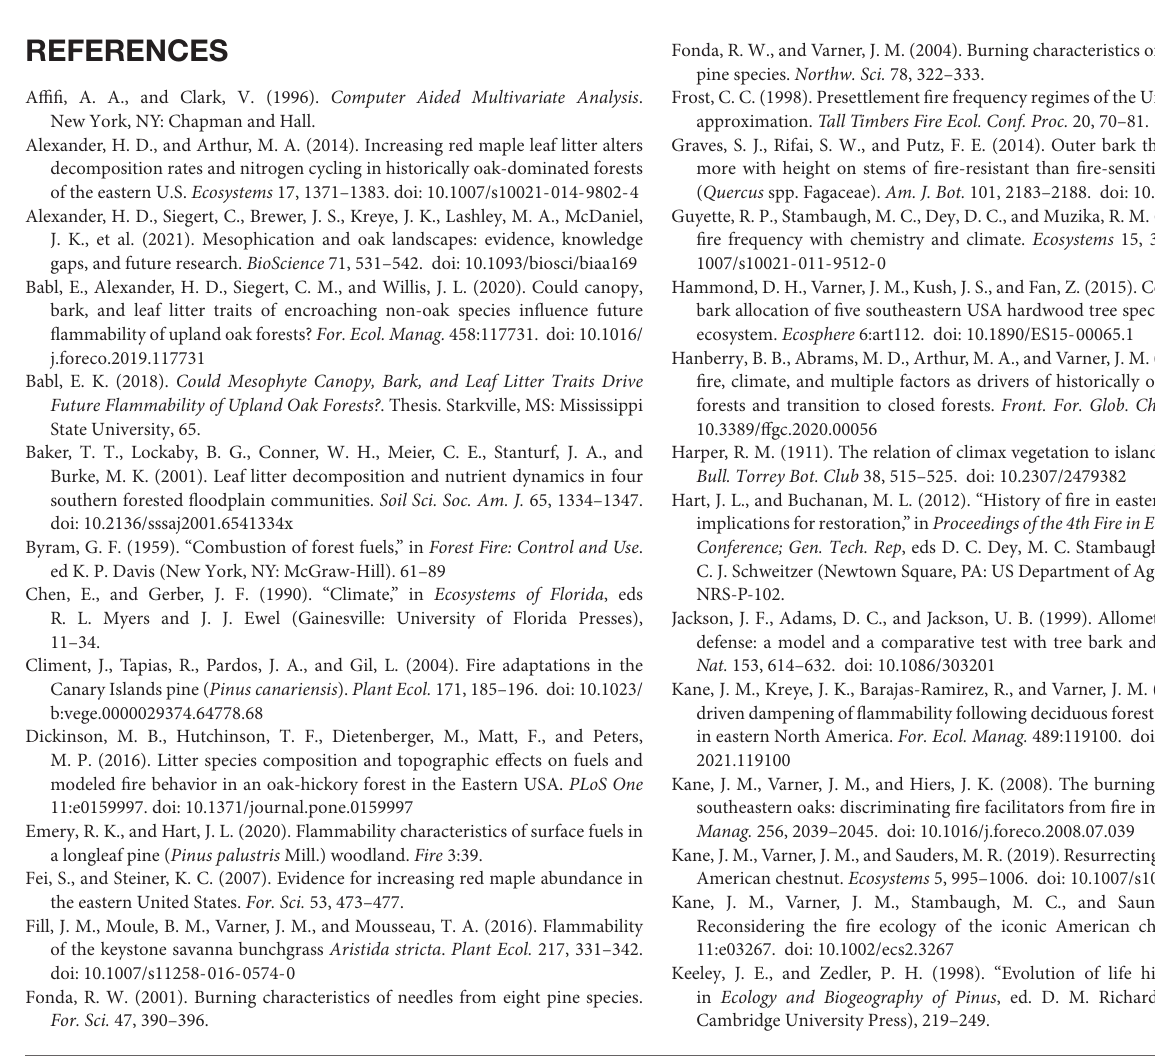
Supplementary Table 1 | Litter flammability metrics for 50 species in the southeastern United